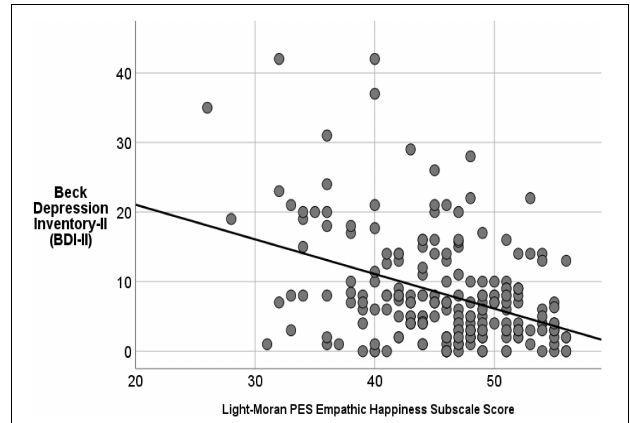
FIGURE 2 | Greater empathic happiness score uniquely predicts lower depression (as measured by the BDI-II) better than anhedonia (as measured by the SHAPS ) or empathic cheerfulness even with Social Desirability included in the model as a covariate ( R 2 = 16%, p < 0.001).